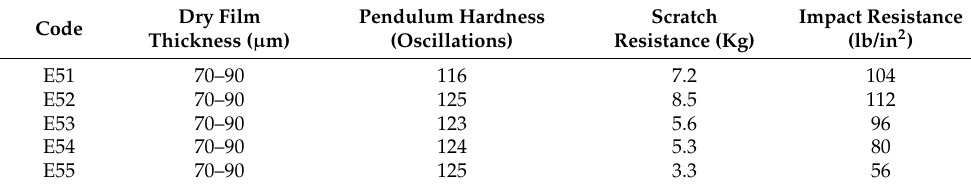
Table 3. The obtained results for pendulum hardness and impact and scratch resistance.